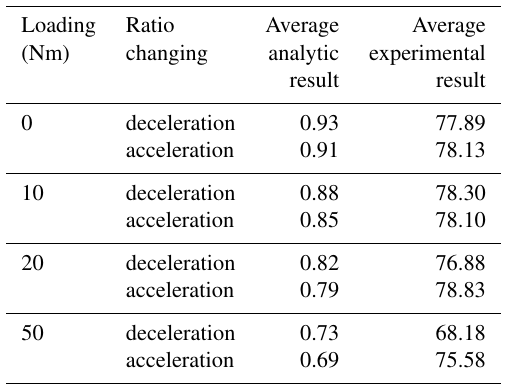
Table 4. Average transmission efficiencies comparison